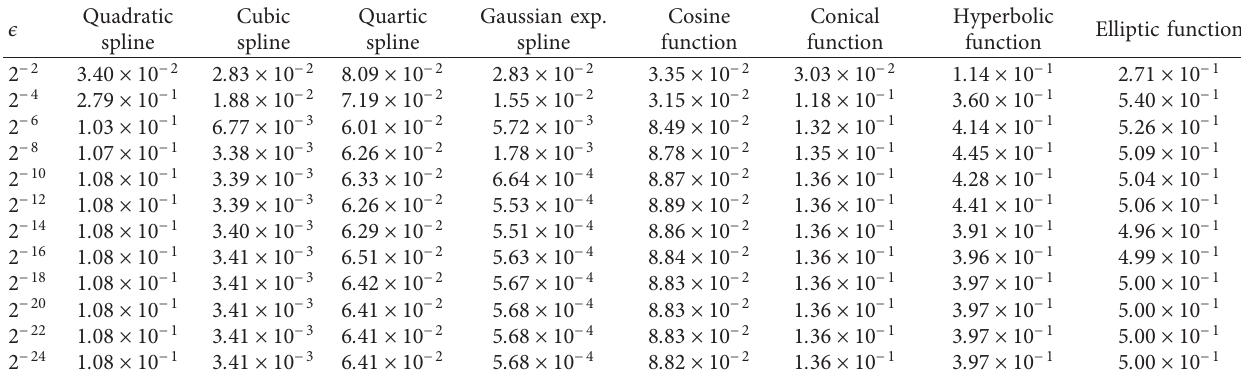
Table 9: Maximum absolute errors for Example 3 for different values of ϵ with linear basis functions.